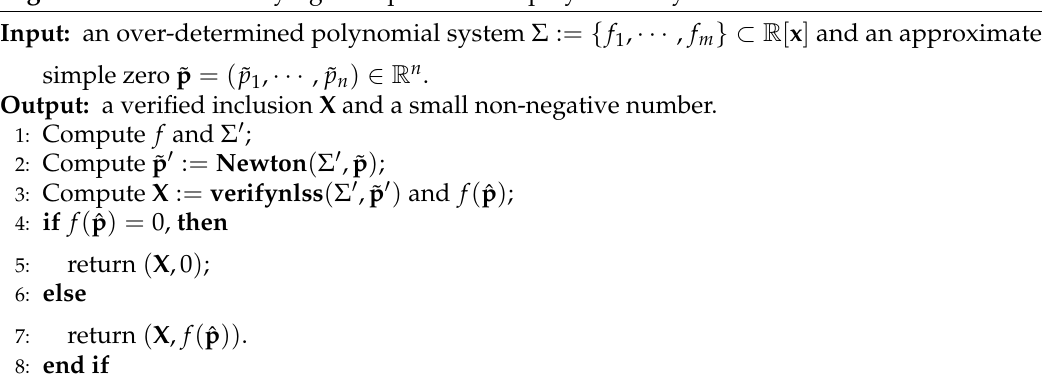
Algorithm 1 VSPS : verifying a simple zero of a polynomial